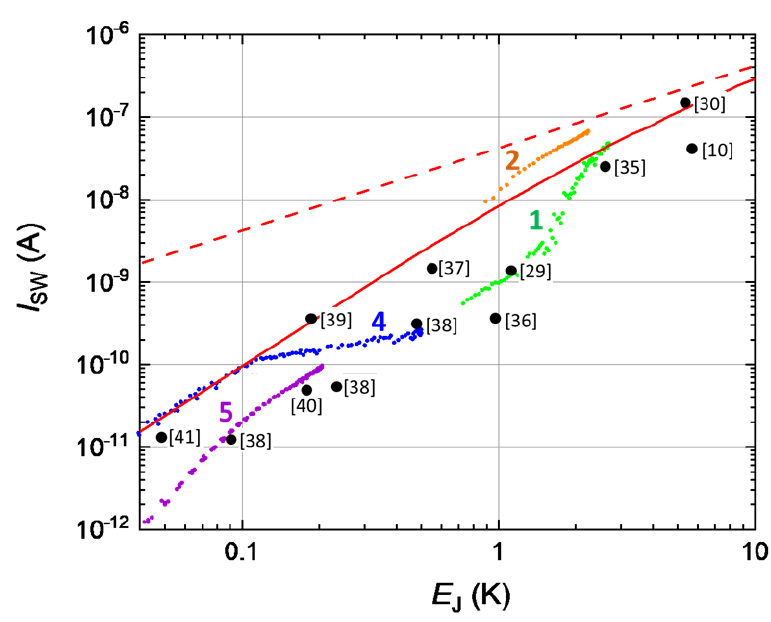
Figure 5. The switching current I SW as a function of E J measured in experiments conducted in this work (the color-coded symbols, the sample numbers correspond to that in Table 1) and by other experimental groups (black dots, the references are given in square brackets). All the data have been obtained at T ≈ 20–50 mK for Al / AlO X / Al junctions. For the values of I SW measured at B (cid:54) = 0 the Josephson energy E J ( B ) was calculated using Equation (2). The dashed red line corresponds to ( E ) (Equation (1)), the solid red curve—to the switching the Ambegaokar–Baratoff dependence I AB J C current predicted by the IZ theory in presence of additional V noise = 24 µ V generated by the biasing scheme (see Appendix